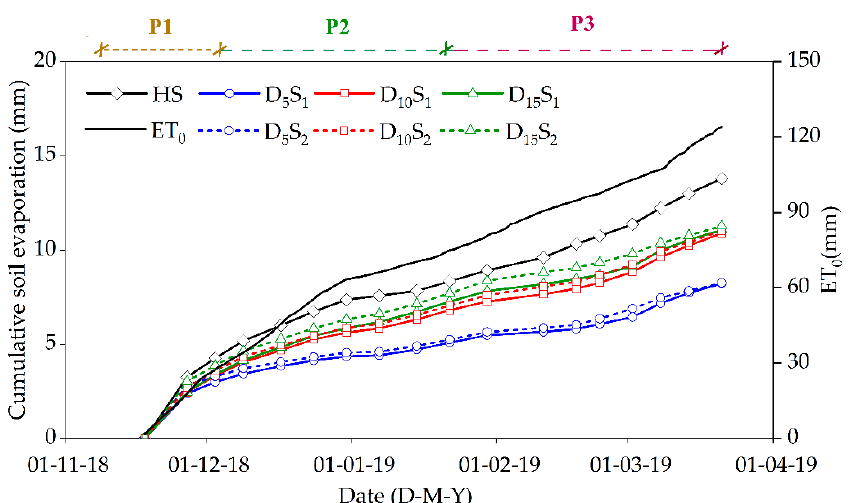
Figure 7. Cumulative soil evaporation of the homogeneous and sand-layered soil columns. Table 2. Soil evaporation in homogeneous and sand-layered soil columns in di ff erent freeze–thaw stages (unit: